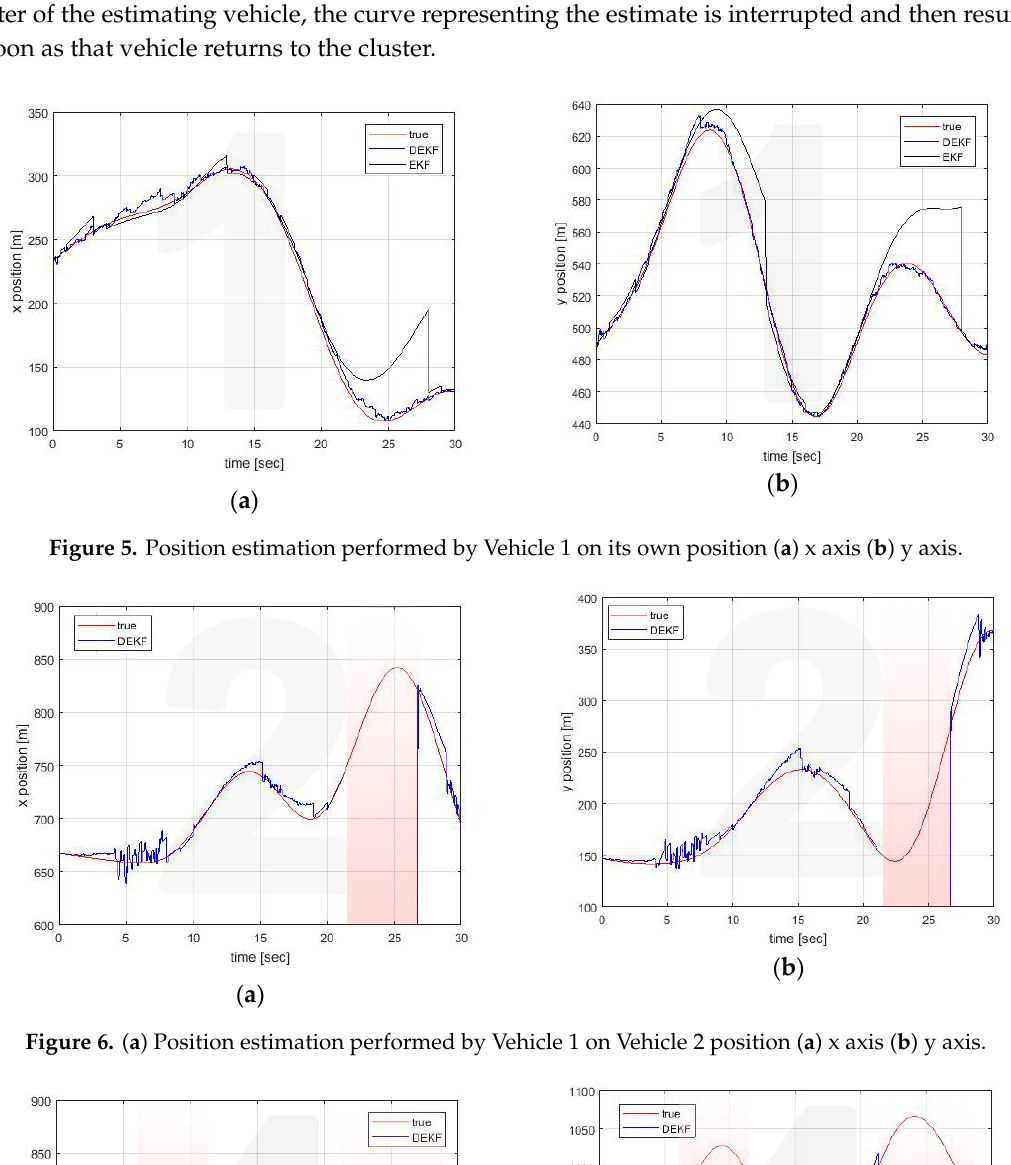
( a ) ( b ) Figure 8. Position estimation performed by Vehicle 4 on its own position ( a ) x axis ( b ) y axis. ( a ) ( b ) Figure 9. Position estimation performed by Vehicle 4 on Vehicle 1 position ( a ) x axis ( b ) y axis.